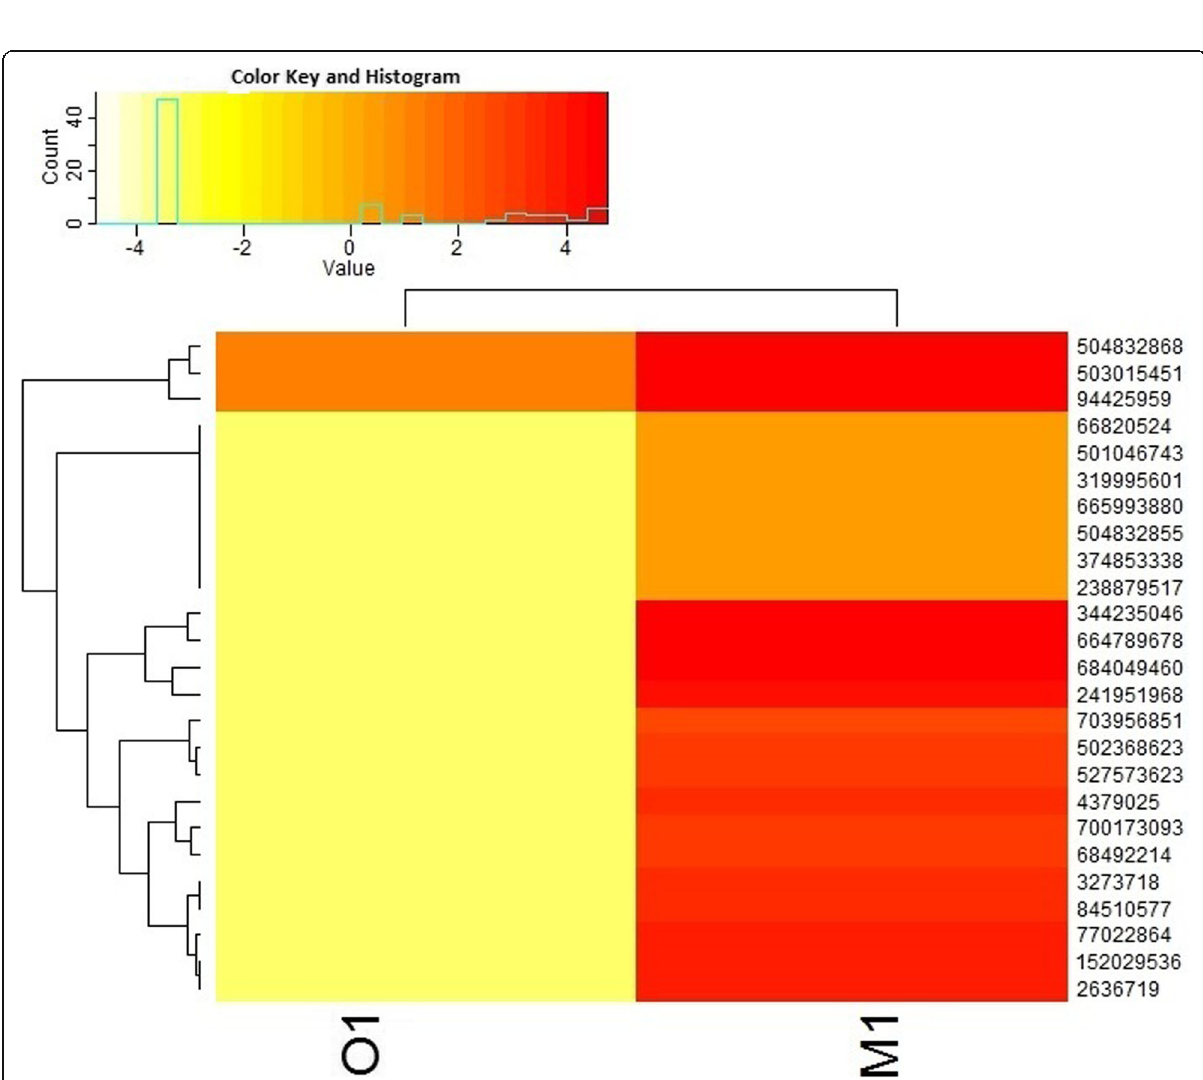
Fig. 2 Heat map showing expression of top 25 expressed genes in M1 compared to O1, with p value ≤ 0.05. The details description of the gene IDs is shown in Table